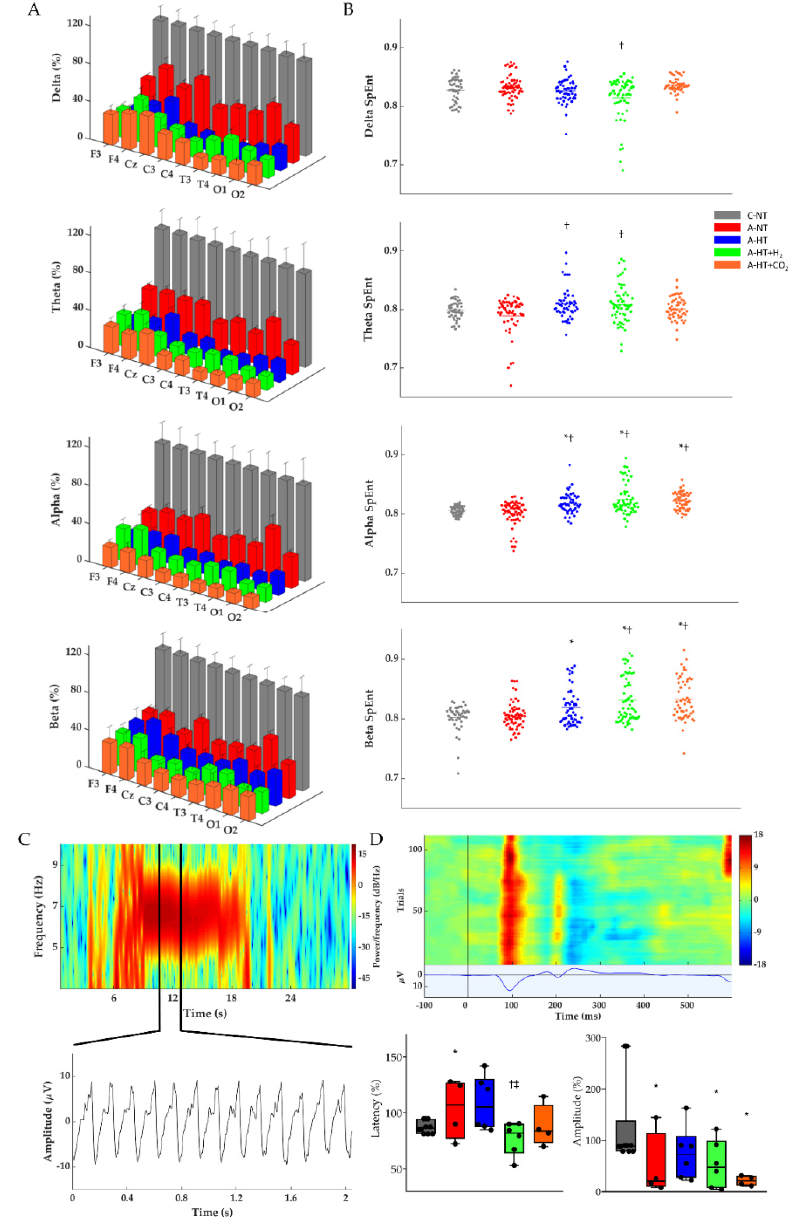
Figure 6. ( A ) Average power spectral density (PSD) changes in each experimental group for the four main frequency bands at the end of the 48 h observation period. All PSDs were normalized to their respective control values for each lead. Delta, theta, alpha, and beta PSDs across the different leads show significant differences between each group. ( B ) Corresponding individual spectral entropy (SpEnt) values in each group. ( C ) Representative spectrogram of a generalized seizure in a piglet from the asphyxia-normothermia group (~7 Hz) which could be detected by all 9 leads. Below the spectrogram, we highlighted a 2 s-long spike-and-wave seizure waveform. ( D ) Representative heat map of the recorded VEP trials with their average VEP waveform below. The two box plots show the latency and peak amplitudes of the P100 components at the 48 h time point in each group, normalized to the respective pre-asphyxia baseline values. The black line represents the median, the box the interquartile range, the whiskers the 10th–90th percentiles, the bullets the raw values. Experimental groups: control-normothermia (C-NT), asphyxia-normothermia (A-NT), asphyxia-hypothermia (A-HT), A-HT supplemented with H 2 (A-HT + H 2 ) or CO 2 (A-HT + CO 2 ), respectively. Data are mean ± SD; * vs. C-NT, † vs. A-NT, ‡ vs. A-HT, p < 0.05.